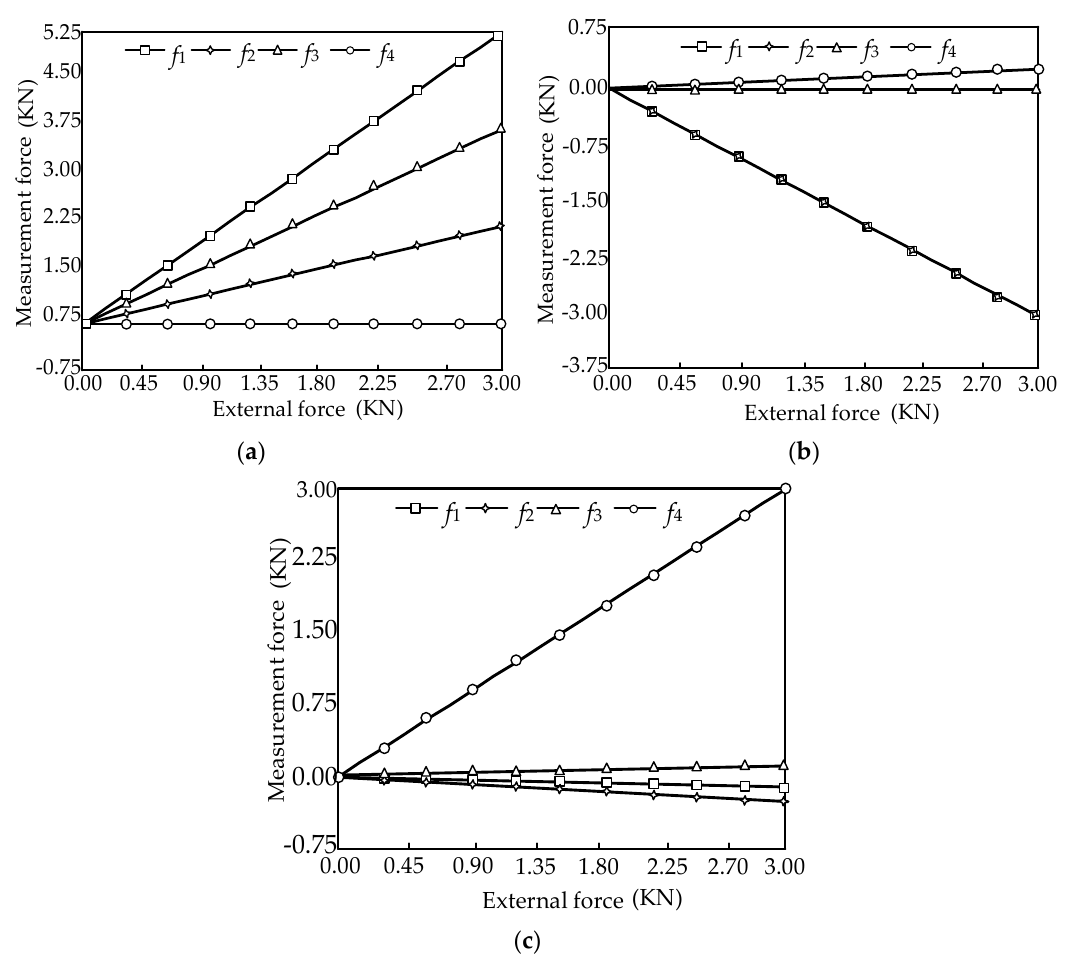
Figure 13. Force diagram of the sensor. ( a ) The relationships between the measurement forces f i ( i = 1, 2, 3, 4) and the external force component F X ; ( b ) The relationships between the measurement forces f i ( i = 1, 2, 3, 4) and the external force component F Y ( c ) The relationships between the measurement forces f i ( i = 1, 2, 3, 4) and the external force component F Z .